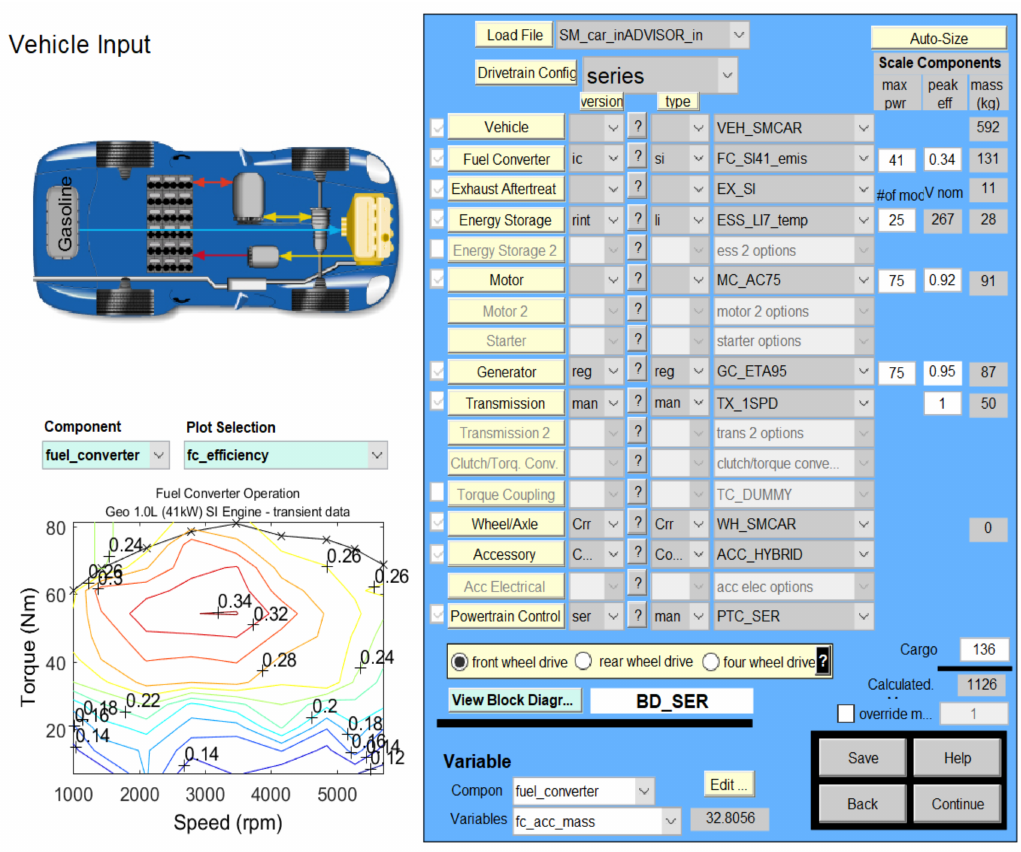
Figure 3. The setup ADVISOR page of the input HEV